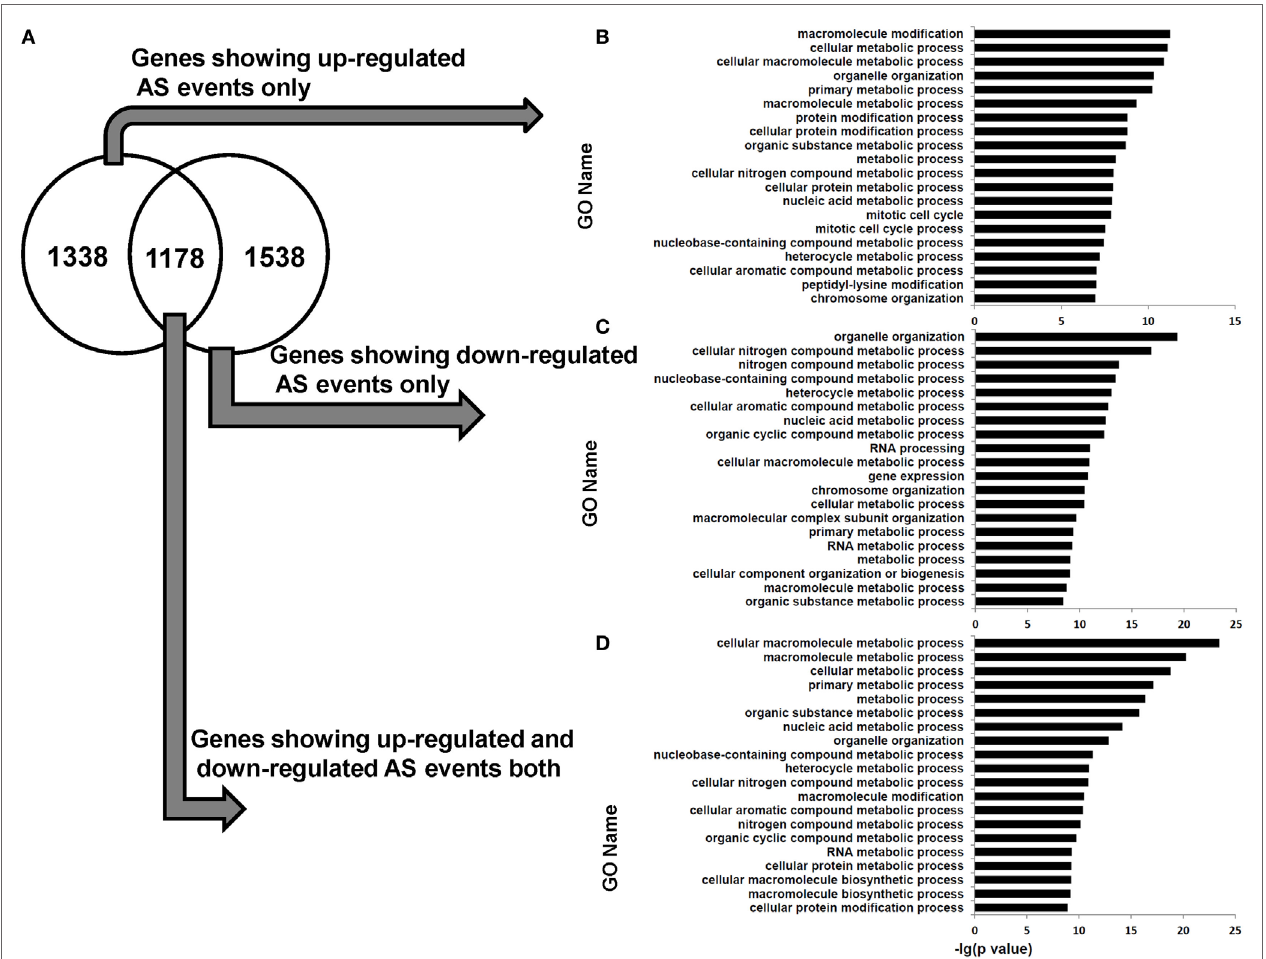
FigUre 7 | Venn diagram and functional enrichment analysis for the genes showing upregulated and downregulated AS events in human dCD8 T cells. (a–D) Venn diagram (a) and GO annotation (B–D) for the genes showing upregulated (FDR < 0.05 with ΔΨ > 0.05) and downregulated (FDR < 0.05 with ΔΨ < − 0.05) AS events in human dCD8 T cells with respect to autologous pCD8 T cells. The five types of AS events including SE, MXE, A5SS, A3SS, and RI were combined together. The top 20 GO terms (biological process) were indicated (B–D) . Abbreviations: GO, gene ontology; FDR, false discovery rate; SE, skipped exon; MXE, mutually exclusion exons; A5SS, alternative 5’ splice site; A3SS, alternative 3’ splice site; RI, retained